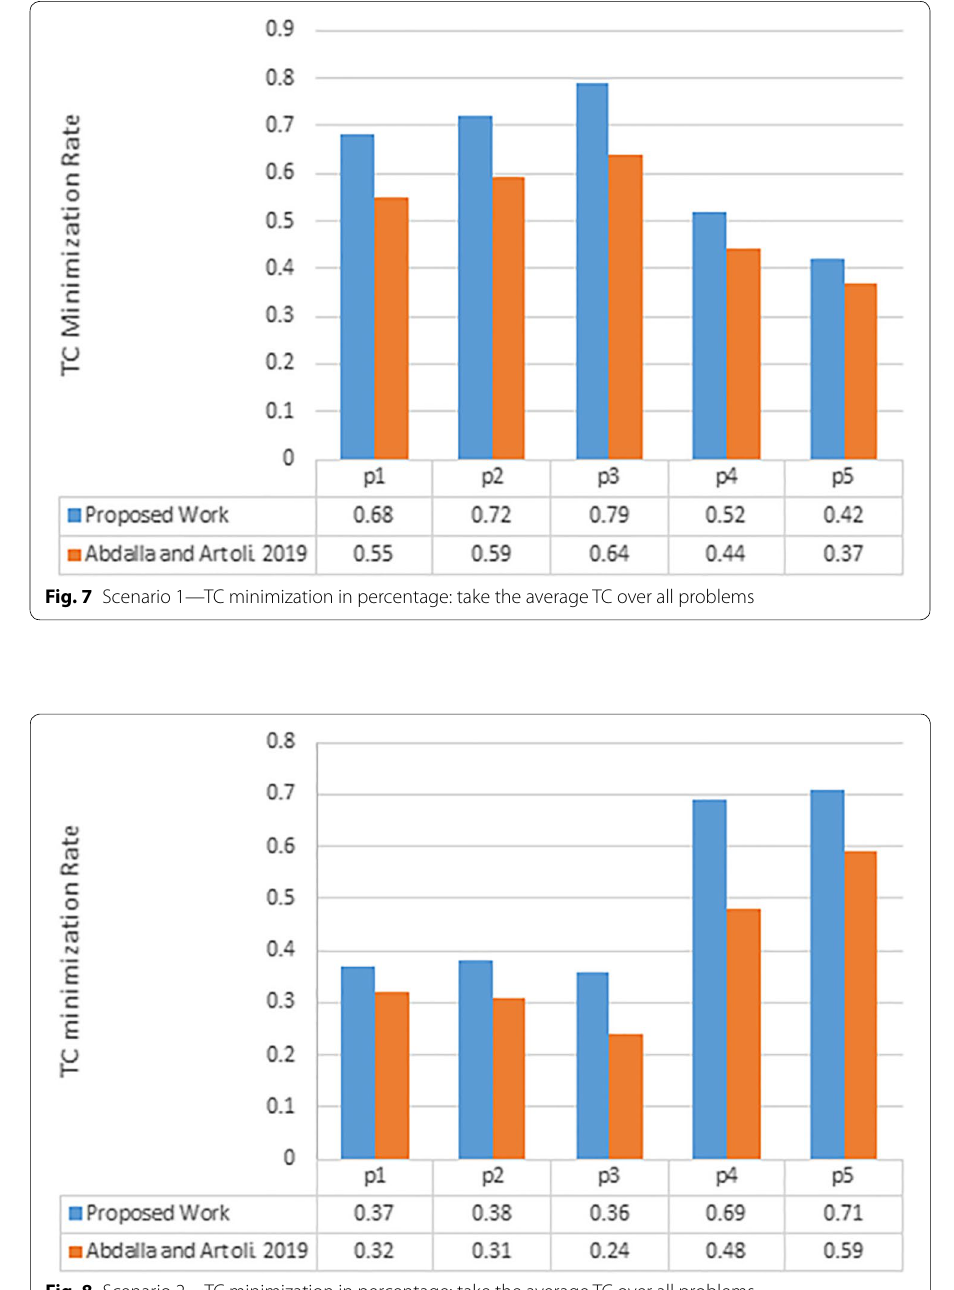
Fig. 8 Scenario 2—TC minimization in percentage: take the average TC over all